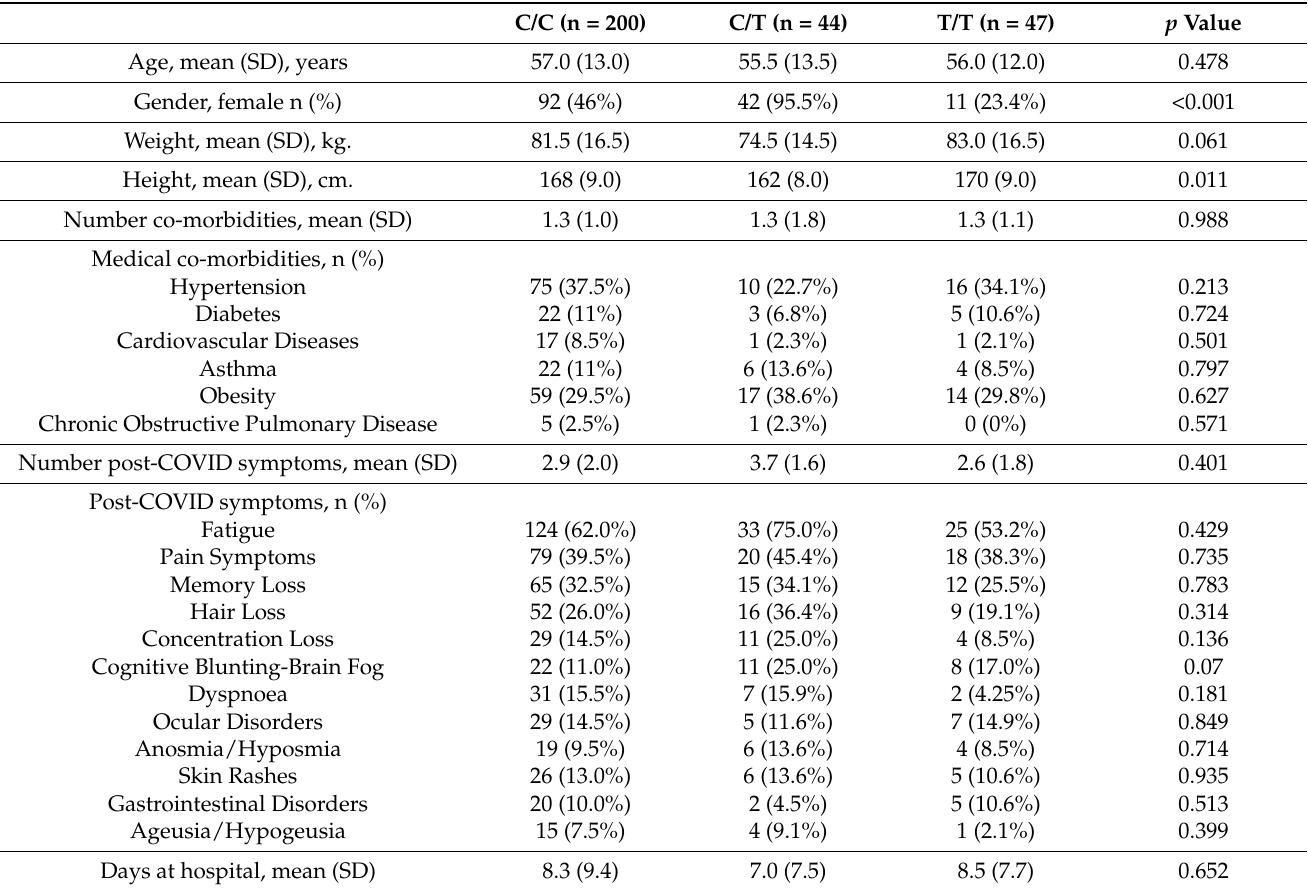
Table 2. Pre-Infection data and post-COVID symptoms according to ACE2 rs2285666 Polymorphism Genotype (n = 291).